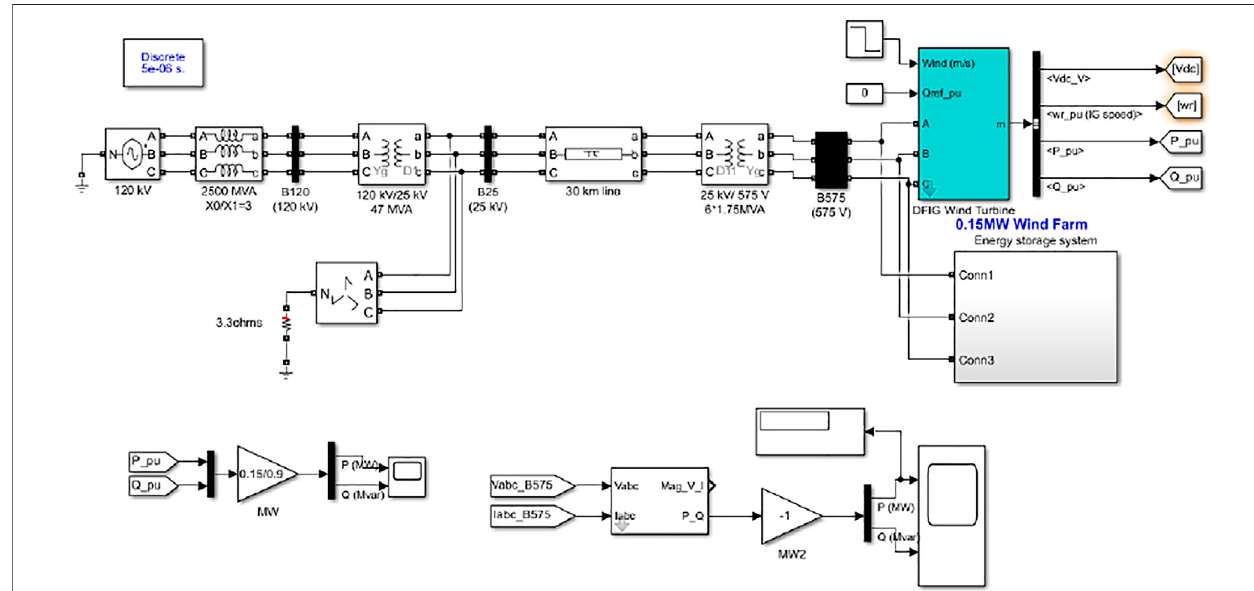
FIGURE 12 | Grid connection model diagram of the wind energy storage system.